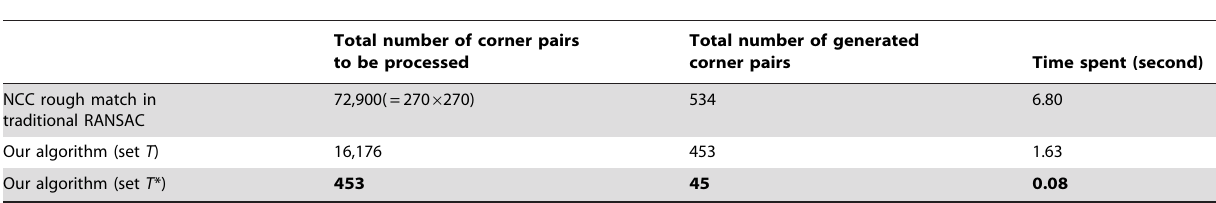
Table 2. Efficiency comparison between traditional RANSAC and our algorithm (II).